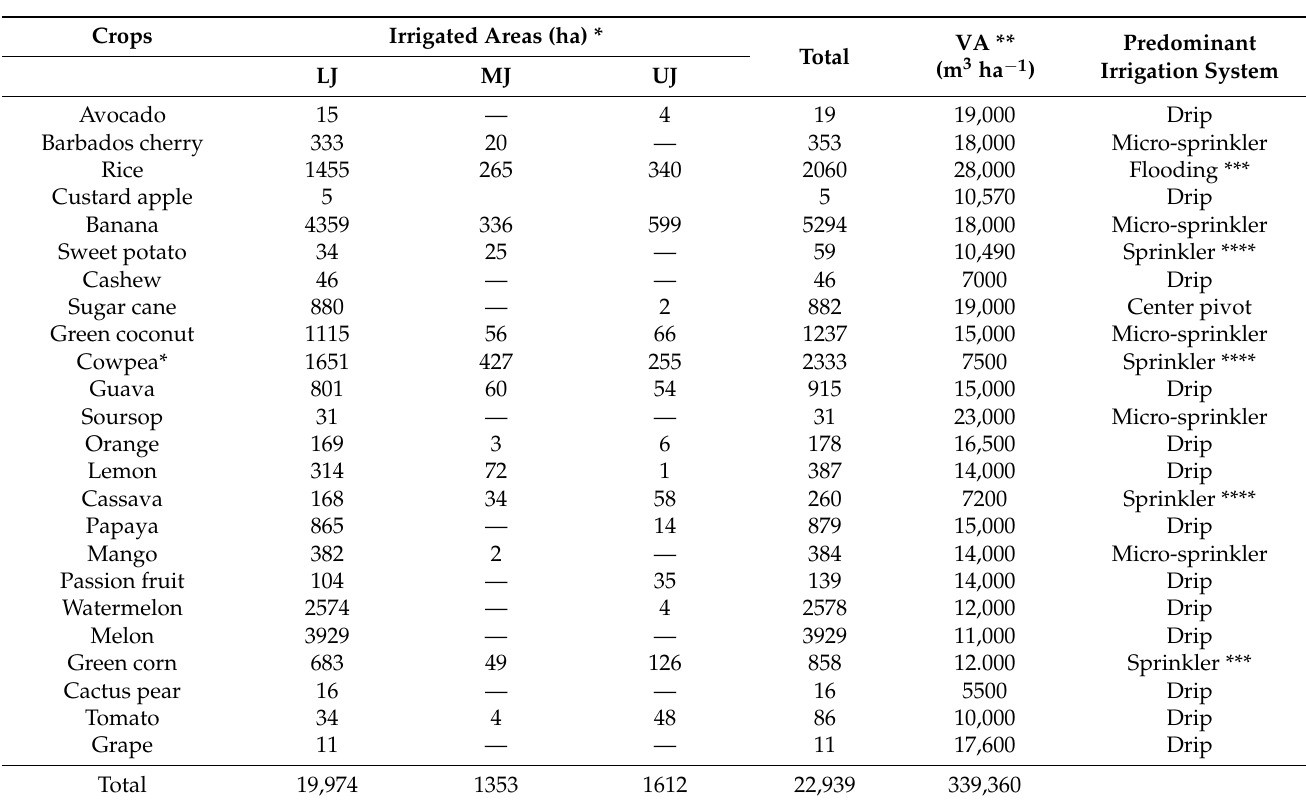
Table 1. Crops, irrigated areas and gross irrigation volumes applied in the Jaguaribe River sub-basins in 2017. Data sources: